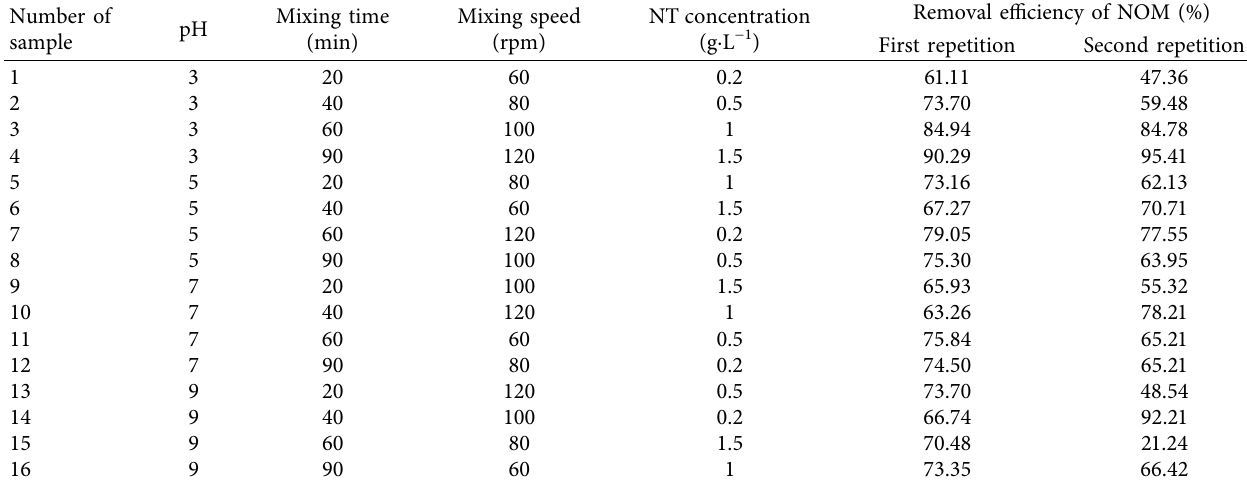
Table 3: Removal percentage of natural organic matter at a concentration of 5mg · L − 1 .